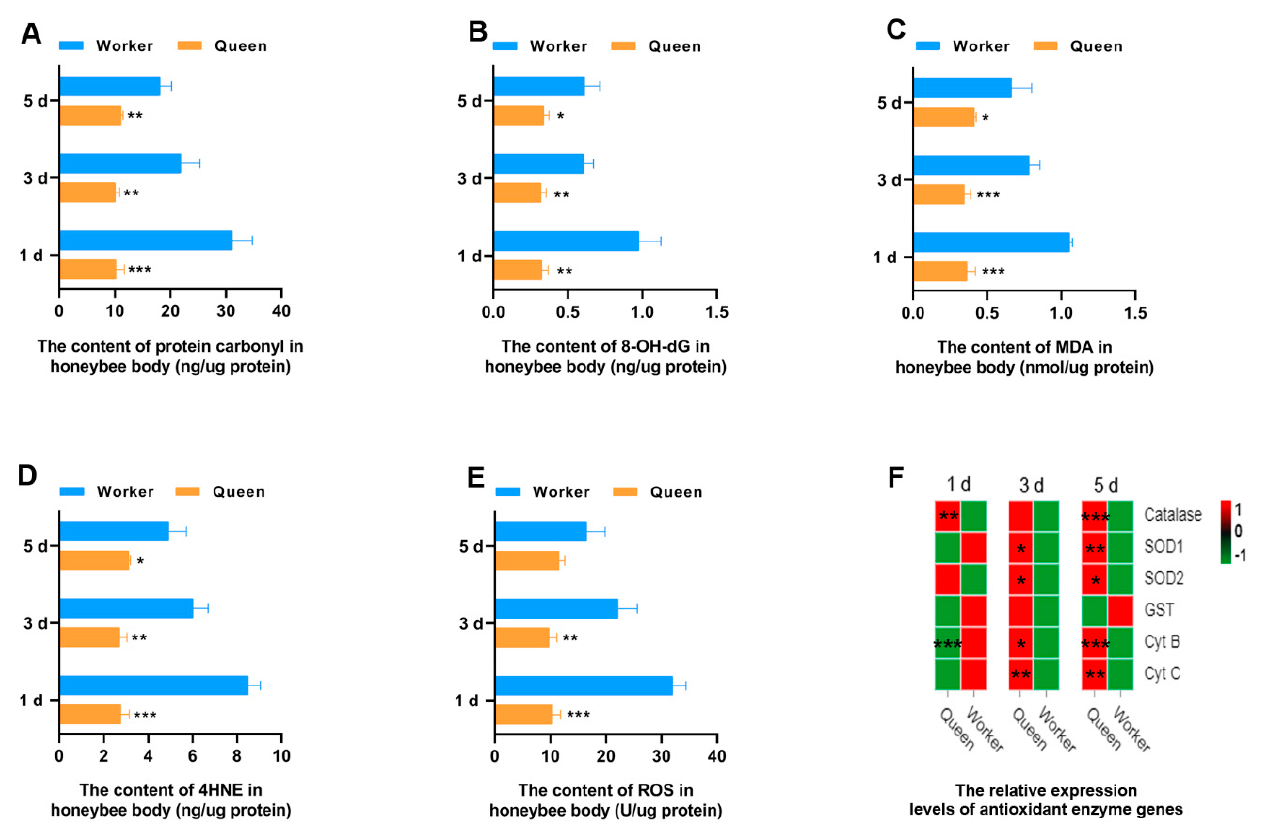
Figure 1. Antioxidant property. * represents p < 0.05, ** represents p < 0.01, *** represents p < 0.001, N queen = 9, N worker = 12.